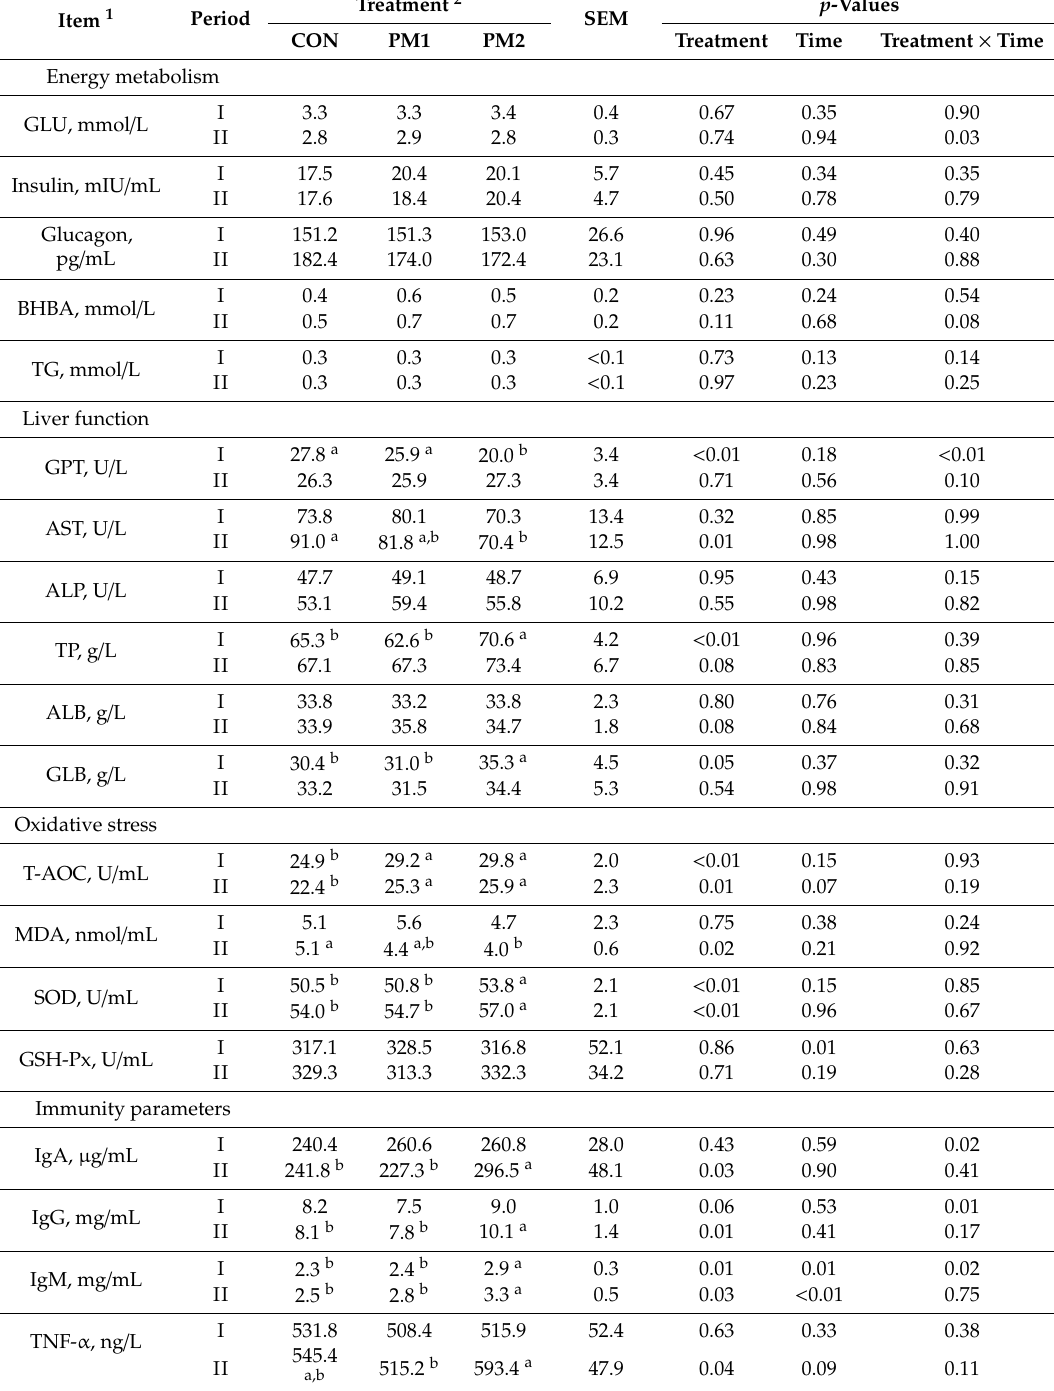
Table 3. E ff ects of paper mulberry silage on the blood parameters of dairy